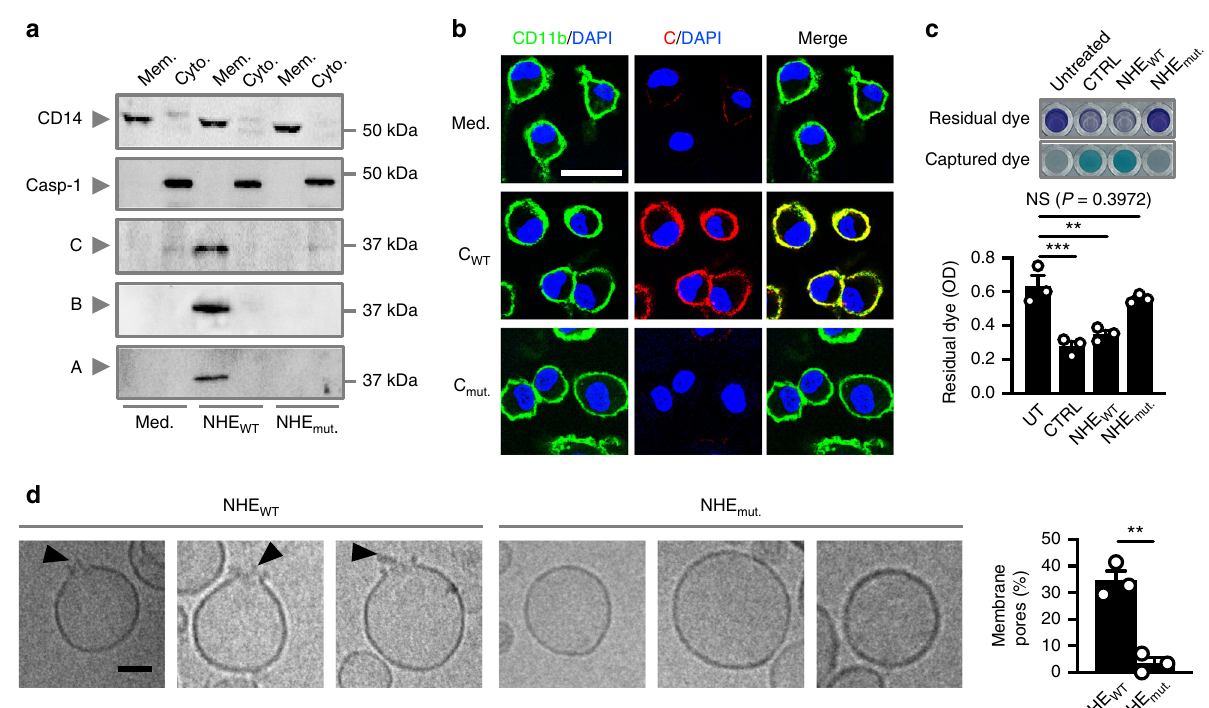
Fig. 9 The transmembrane domain in NHE-C mediates membrane binding and pore formation. a Immunoblot analysis of CD14, caspase-1, C, B, and A of unprimed WT BMDMs left untreated or assessed 1 h after treatment with NHE WT or NHE mut. . Mem, membrane fraction; Cyto, cytosolic fraction. b Immuno fl uorescent analysis of CD11b (green) and C (red) in unprimed WT BMDMs left untreated or assessed 1 h after treatment with C WT or C mut. . c Colorimetric analysis (top) and the absorbance (OD, bottom) of liposomes left untreated, sonicated for 5 mins at 100 amplitude (CTRL) or assessed 30 mins after treatment with NHE WT or NHE mut. . d Cryo-transmission electron microscopy analysis of liposomes assessed 1 h after treatment with NHE WT ( n = 451) or NHE mut. ( n = 545). Quanti fi cation of membrane pores of liposomes (right). Arrowheads indicate pores d . Scale bar, 25 μ m b , 50 nm d . NS,